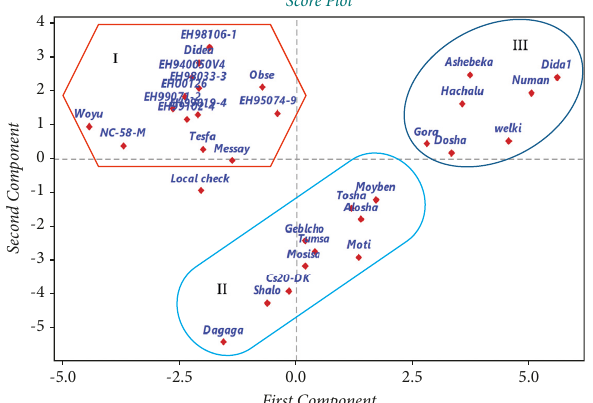
Figure 3: PCA Biplot showing the association between the 22 traits used and the 31 varieties considered; the red dots represent faba bean varieties used in the present